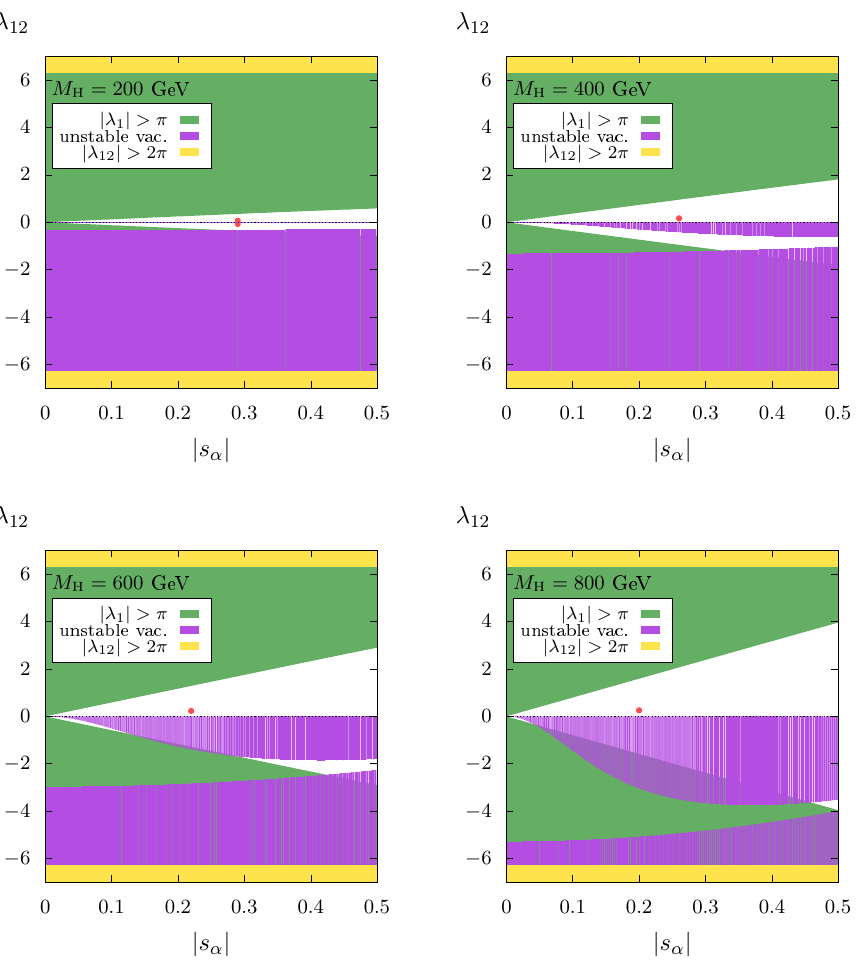
Figure 8 . Theory constraints on the parameters (cid:21) 12 and s (cid:11) , for di(cid:11)erent M H values. Note that (cid:21) 12 > 0 ( < 0) corresponds to s (cid:11) > 0 ( < 0). The green and the yellow regions are excluded, respec- tively, by perturbativity constraints on the couplings (cid:21) 1 and (cid:21) 12 . The purple region is excluded by the vacuum stability constraint. The white regions correspond to the allowed parameter space, and the red dots correspond to the chosen benchmark